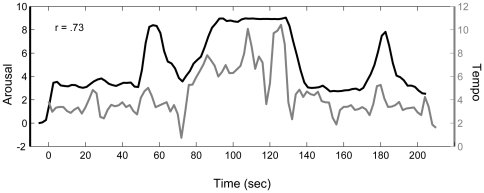
Correlation between tempo and mean arousal for the expressive performance for one participant.For this participant, the optimal lag time was −5.4 seconds and time shifted arousal ratings are shown. (r = .73, p<.0001)